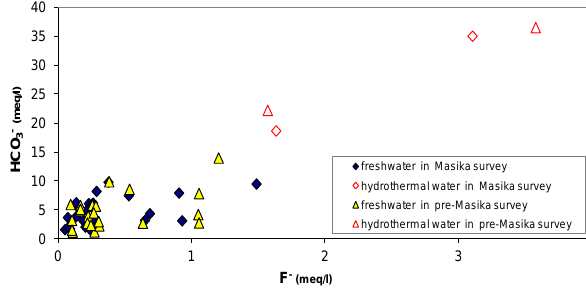
Fig. 4. Sodium vs. fluoride scatter diagram of all groundwater samples.